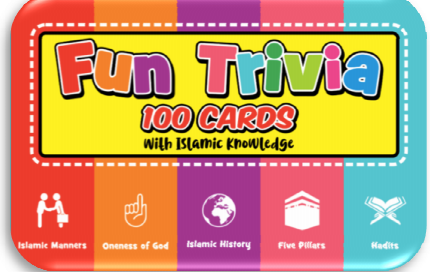
Figure 3. The front side of the trivia cards